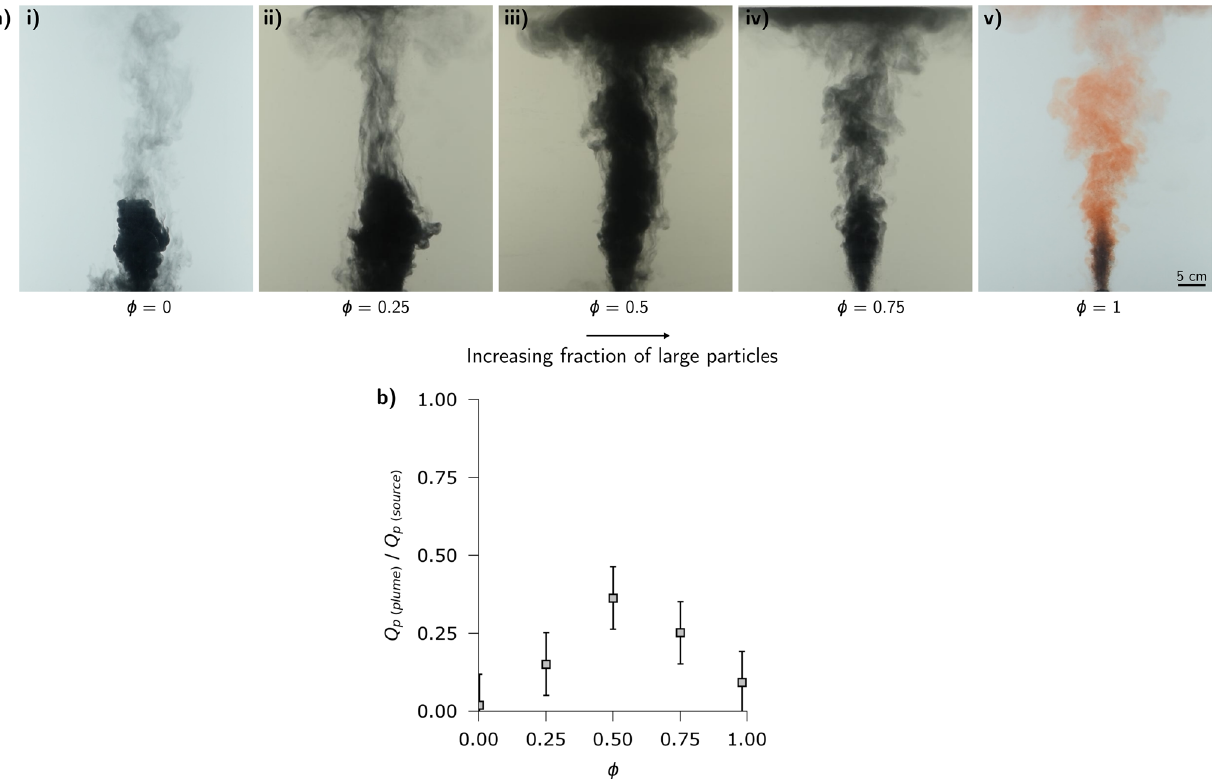
Figure 4. Experimental images (exp. 18–22) illustrating how the fraction of fluid and particles rising from the top of the fountain varies with the fraction, φ , of large particles with U > 1 in the mixture. All frames were taken at approximately 20 s after initial injection.